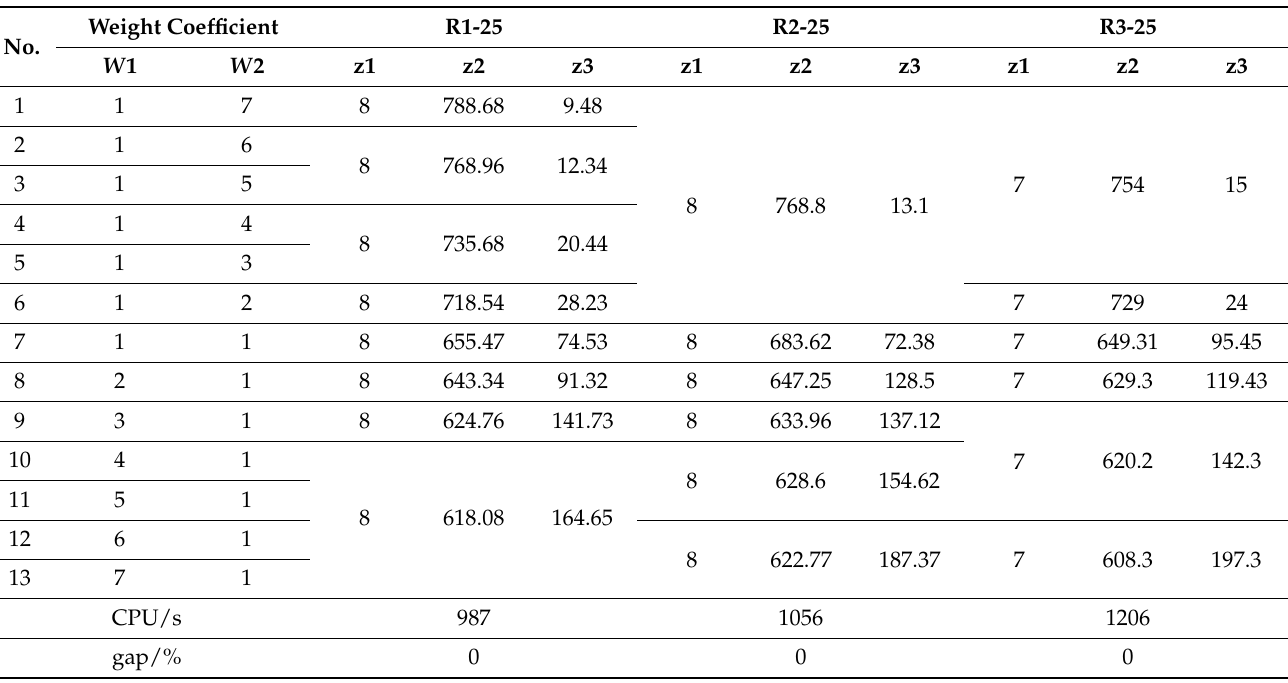
Table 5. Results of MILP model.